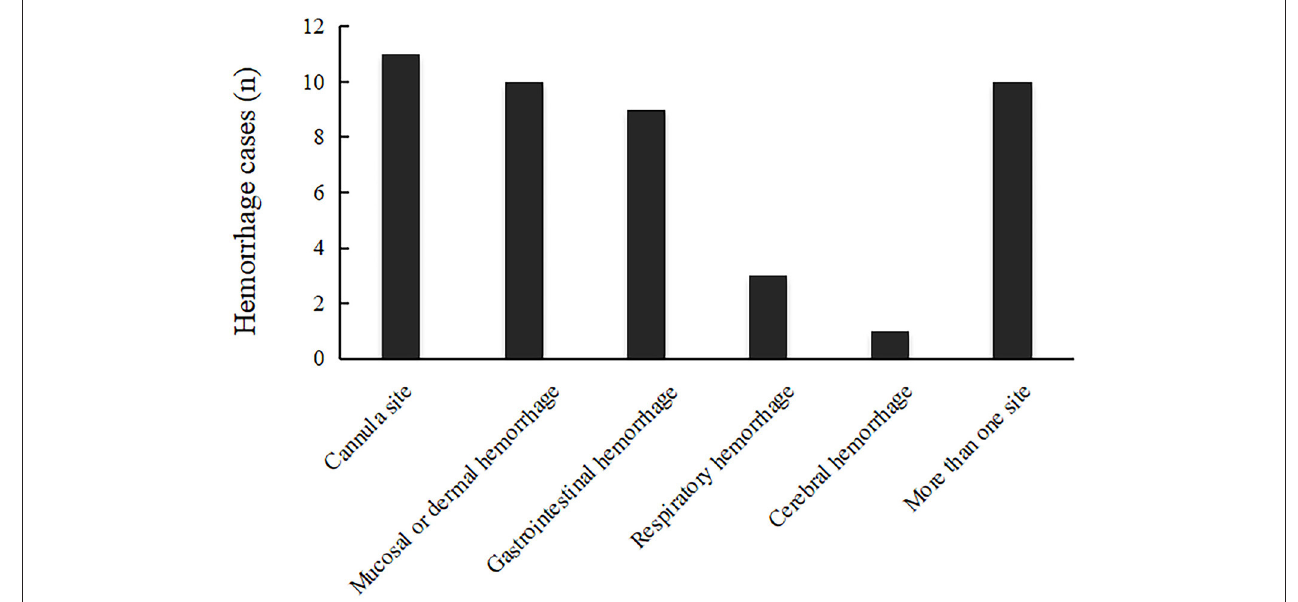
FIGURE 4 | Hemorrhage